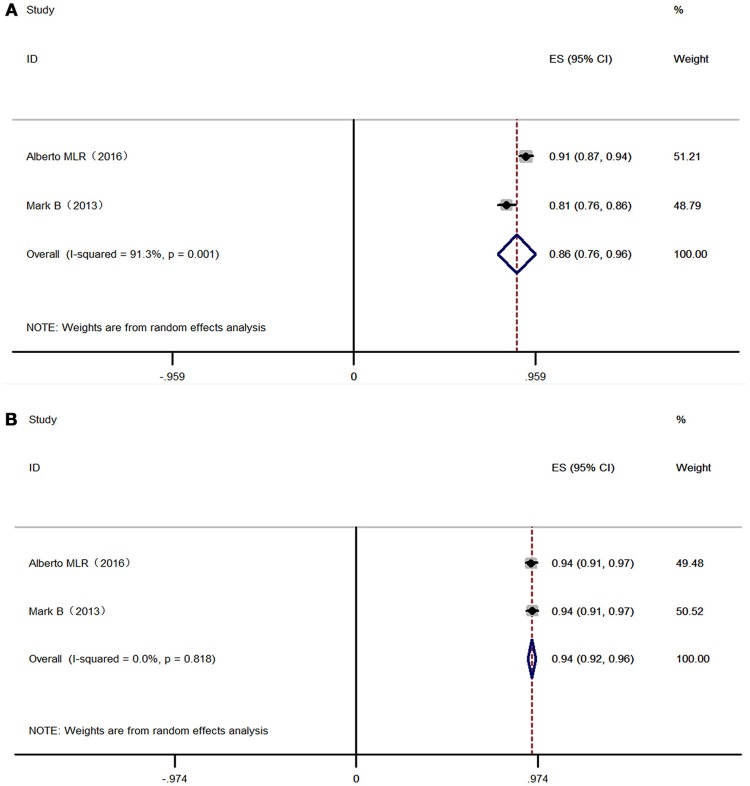
Forest plot of 2-3 NRTI plus LPV /r in virologic suppression. Each risk ratio represents the effect of the second-line treatment in people with HIV with previous ART failure. (A) Intention-to-treat analysis of HIV RNA <400 copies/mL. (B) Pre-protocal analysis of HIV RNA <400 copies/mL. NRTI, nucleoside/nucleotide reverse transcriptase inhibitor; LPV /r, Ritonavir-boosted lopinavir.